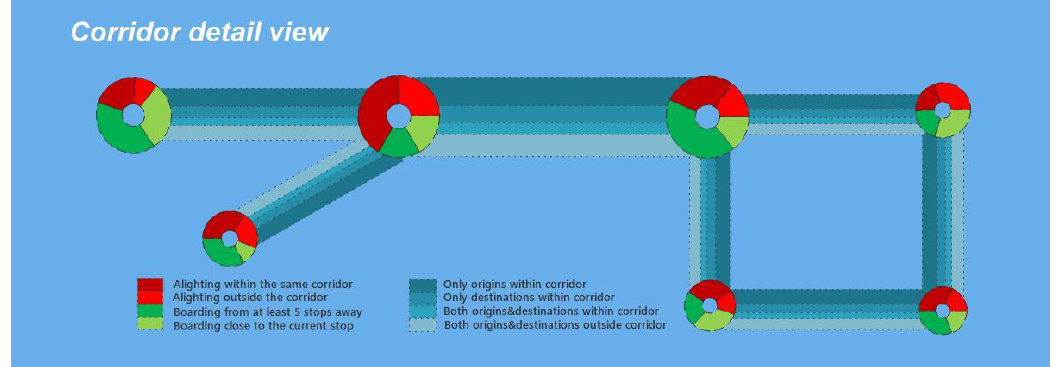
Figure 7. Corridor detail view.